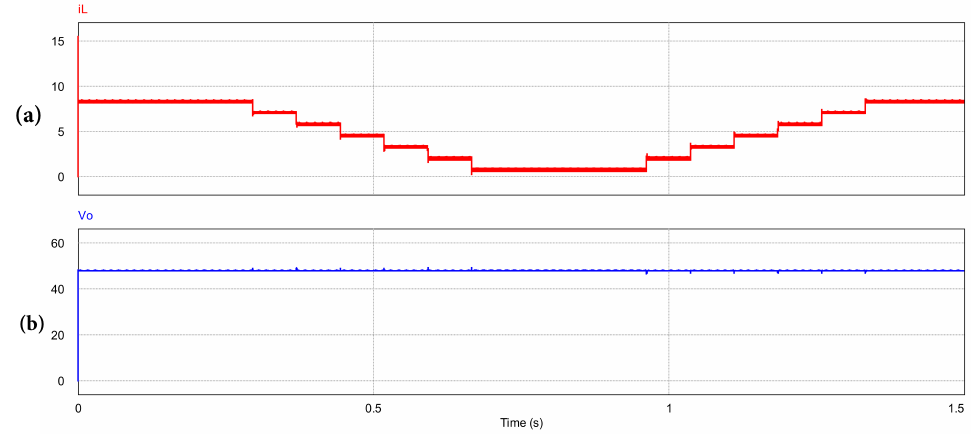
Figure 17. DC-DC full bridge converter 400 W at 48 V with state feedback controller. ( a ) inductor current, ( b ) output voltage.